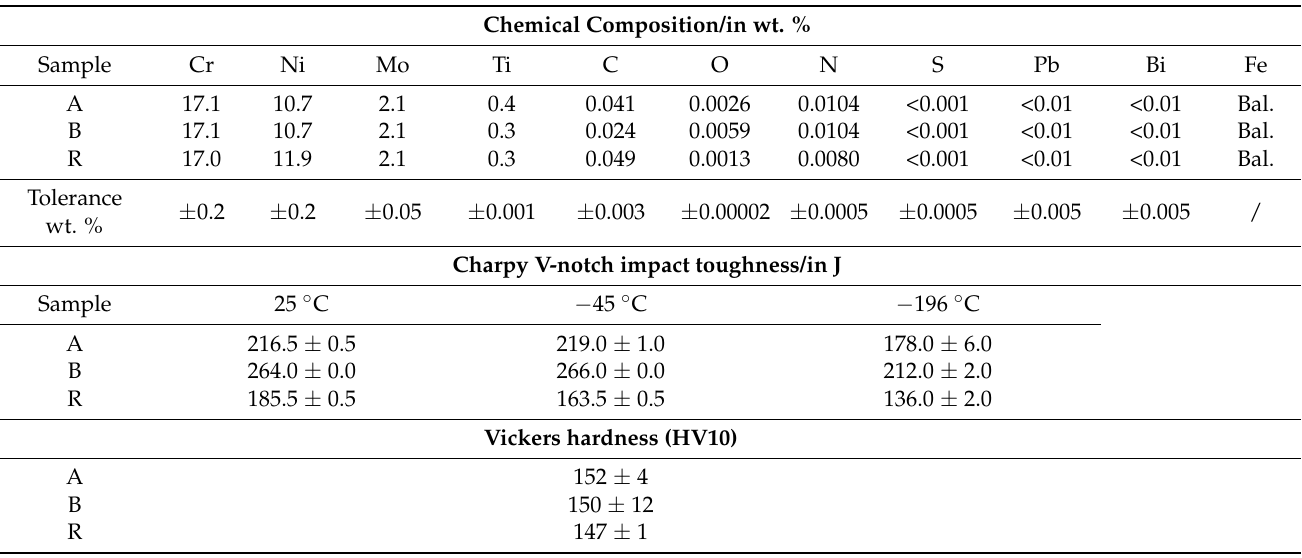
Table 1. Characteristics of Ti-stabilized Cr-Ni-Mo steel plates under investigation. Chemical Composition/in wt.